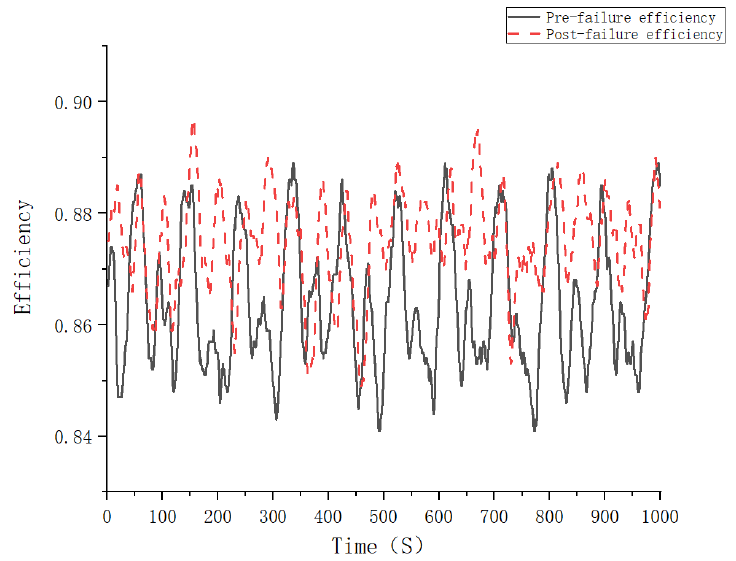
Figure 7. Comparison before and after the